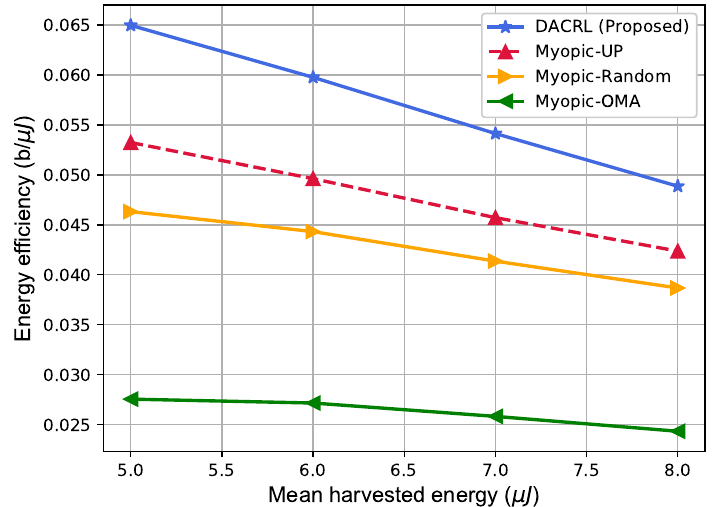
Figure 11. Energy efficiency according to different values of harvested mean energy.